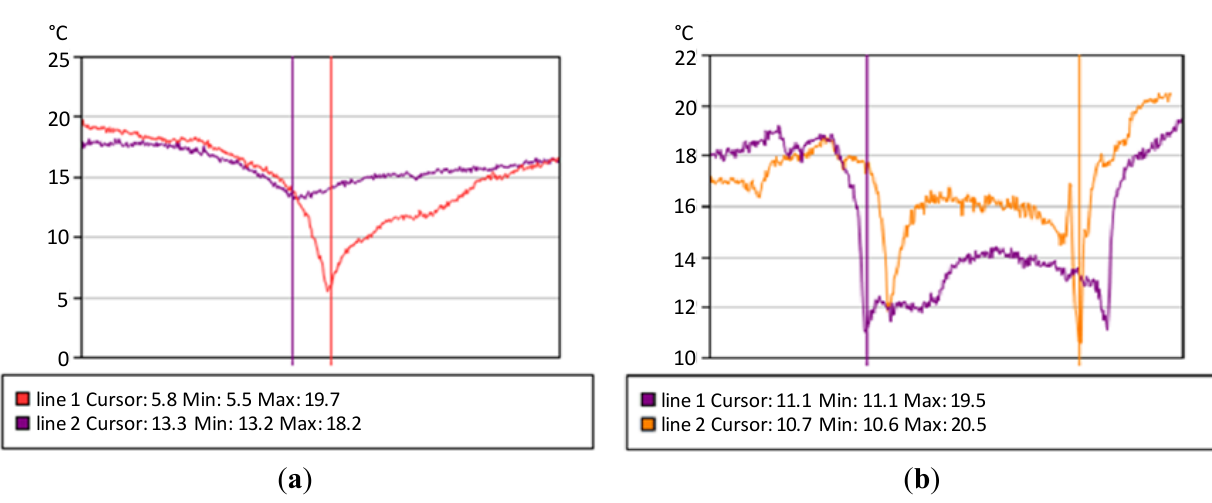
Figure 4. ( a ) Thermographic analyses of a wall and floor leakage points; ( b ) Thermographic analyses of a skylight’s mounting leakage